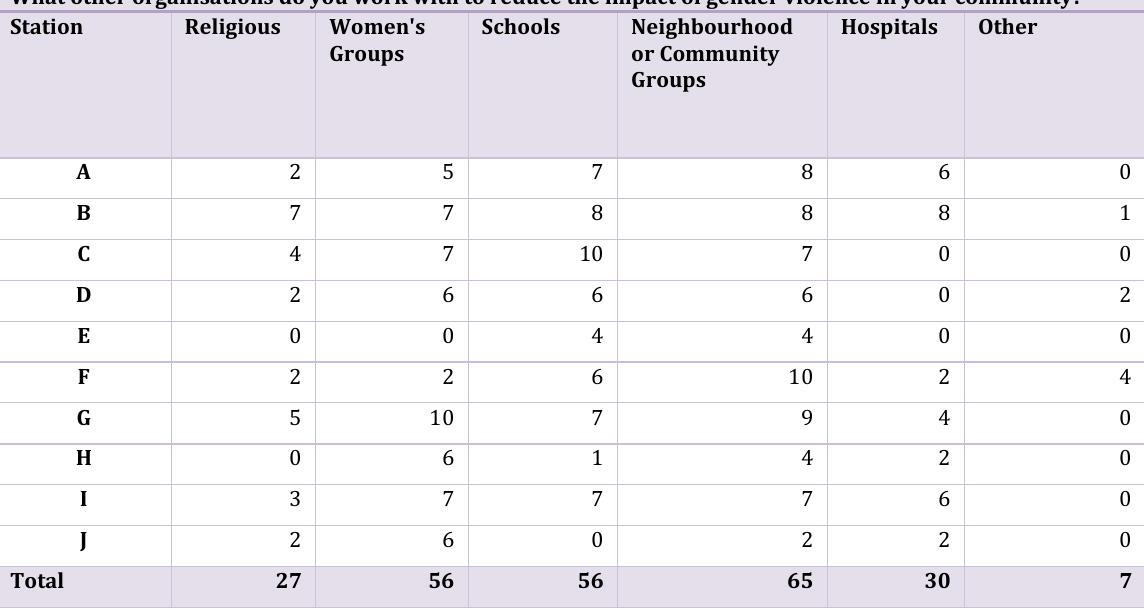
What other organisations do you work with to reduce the impact of gender violence in your community?